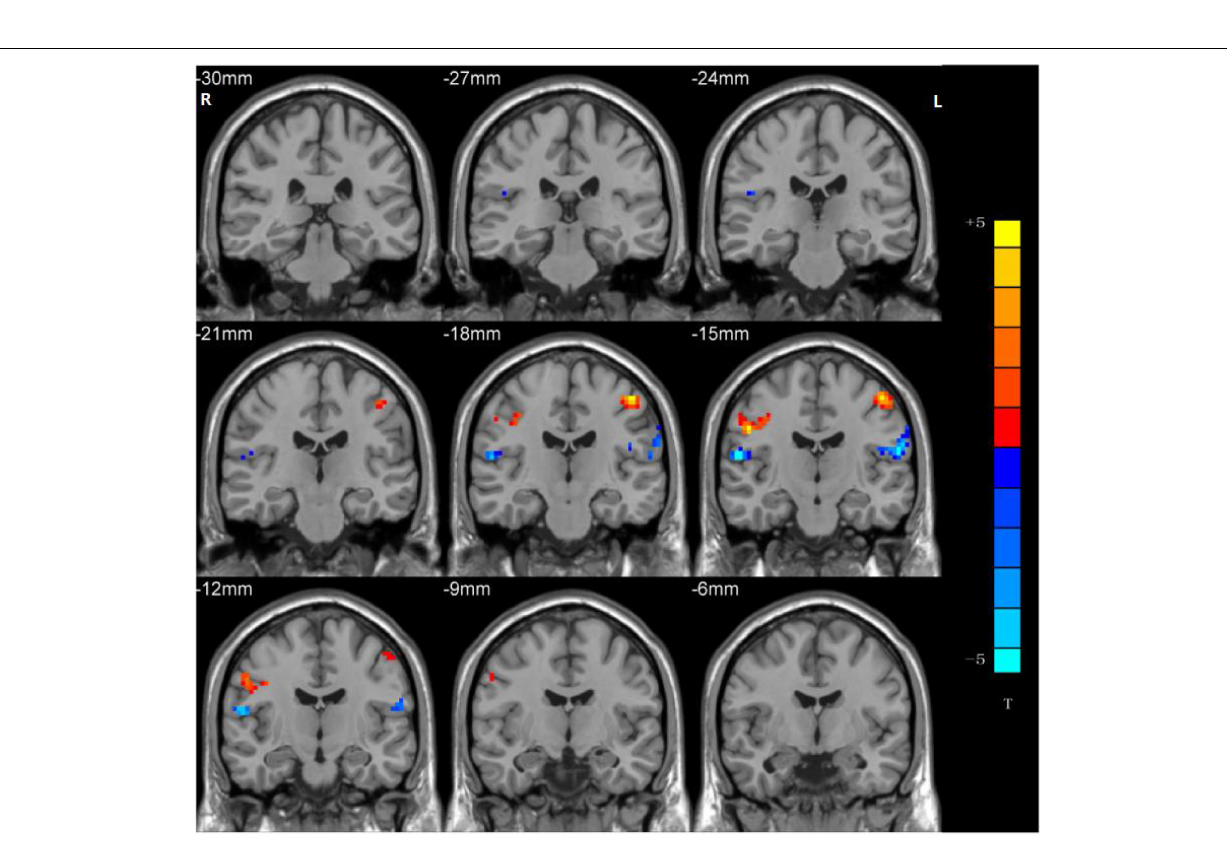
Frontiers in Psychiatry |